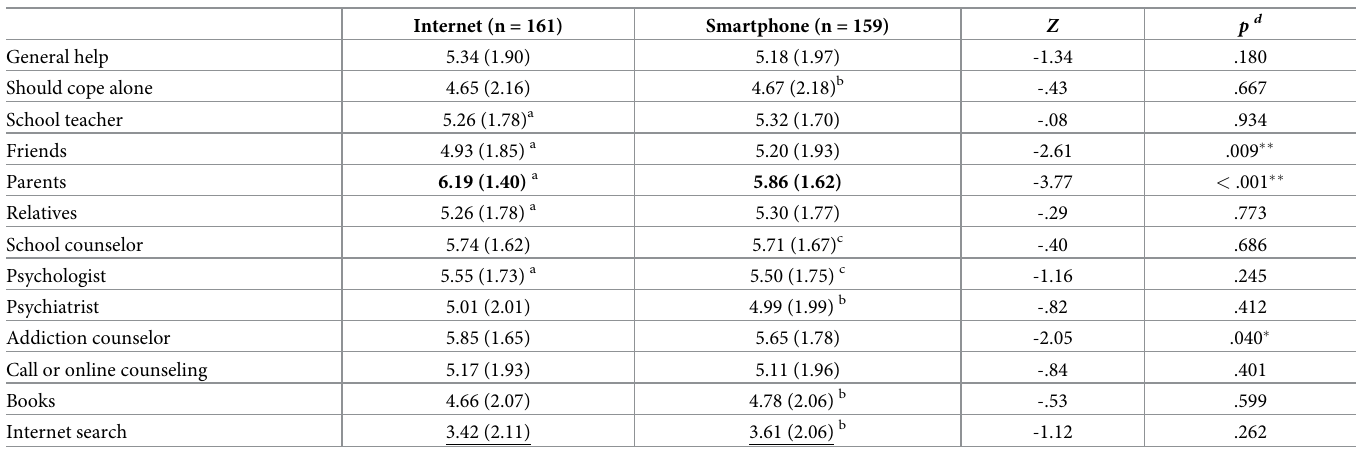
Table 3. Ratings for the likelihood of suggesting help for a person with IGD and